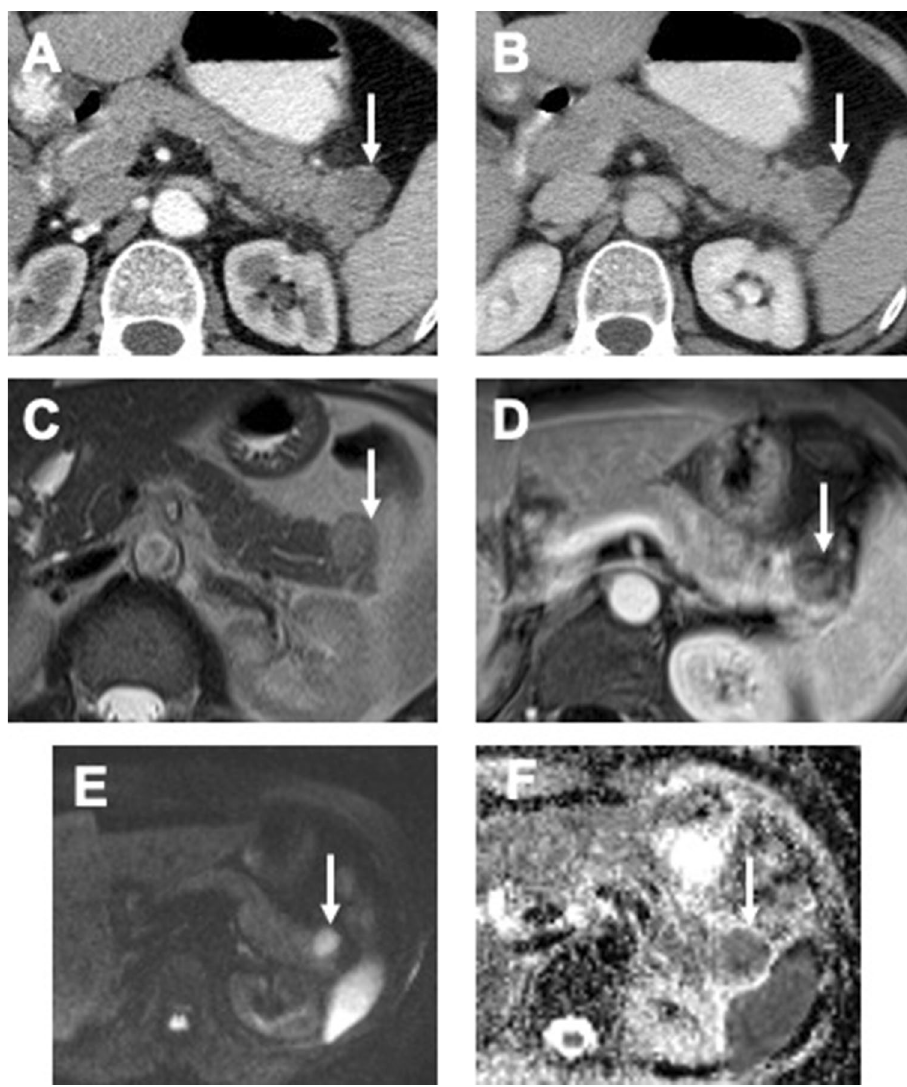
Figure 3. CT and MRI features of ITPN with associated invasive carcinoma. ( A,B ) Axial CT scans in the arterial phase ( A ) and portal venous phase ( B ) demonstrating ITPN lesion in the pancreatic tail (arrows) with well-circumscribed margins and moderate hypointense HU values. ( C ) Axial T2 weighted image of the same patient, tumor (arrow) doesn’t have classical cystic morphology on T2 but is slightly T2 hyperintense compared to pancreatic parenchyma. ( D ) Axial T1 weighted image with fat suppression after CM administration, portal venous phase. Tumor (arrow) shows low inhomogeneous contrast enhancement without invasion of adjacent structures. ( E,F ) Tumor (arrows) shows hyperintensity on axial DWI with b-value 800 s/mm 2 ( E ) and hypointensity on ADC map ( F ), which corresponds the restricted